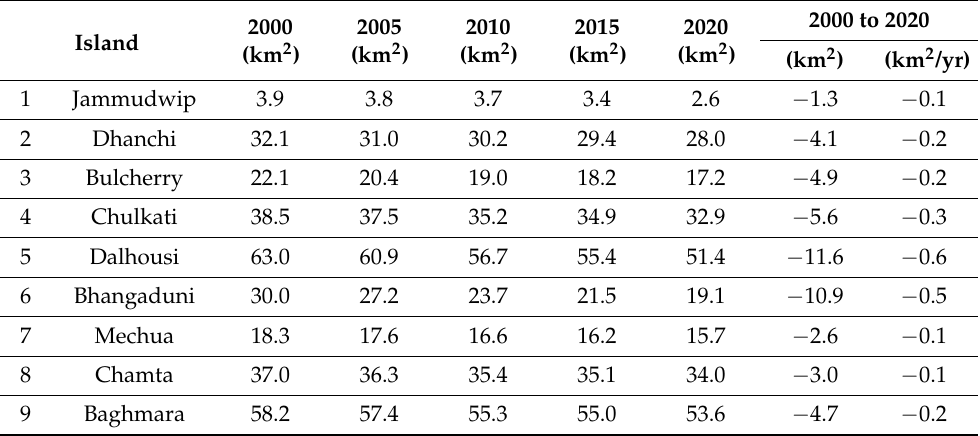
Figure 2. Mangrove area loss/gain in the sea-facing islands (numbers 1 to 9). Shoreline changes on nine ocean-facing islands, where the erosion is concentrated, were analyzed in detail (Figure 2 and Table 2). Land loss between 2000 and 2020 ranged from 1.3 km 2 in Jammudwip to 11.6 km 2 on Dalhousi Island. There was a net total loss of 49 km 2 from these sea-facing islands, all of which (except Jammudwip Island) provide tiger habitats. Table 2. Changes in mangrove forest area on nine islands facing the Bay of Bengal (see Figure 2 for